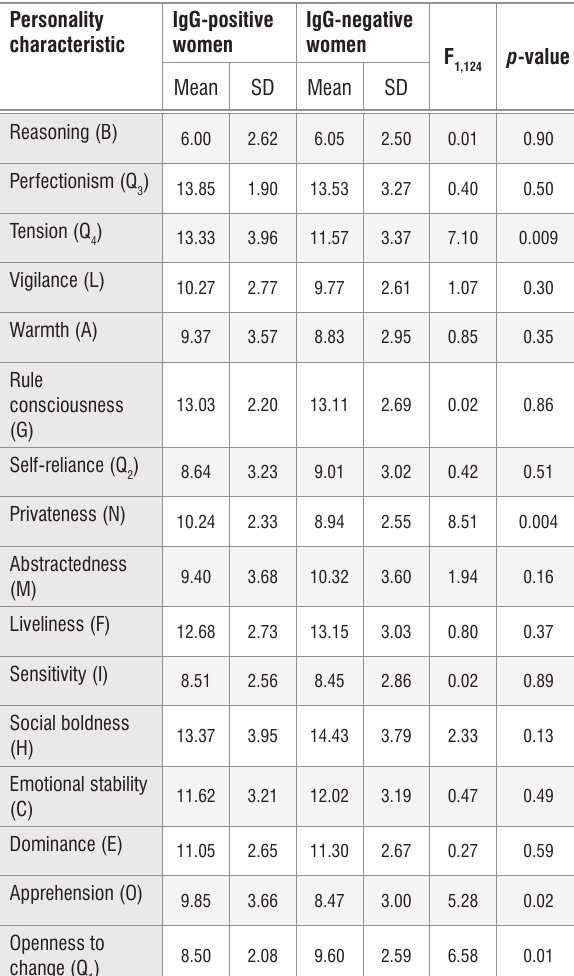
Comparison using multiple univariate ANOVA of personality characteristics in men according to